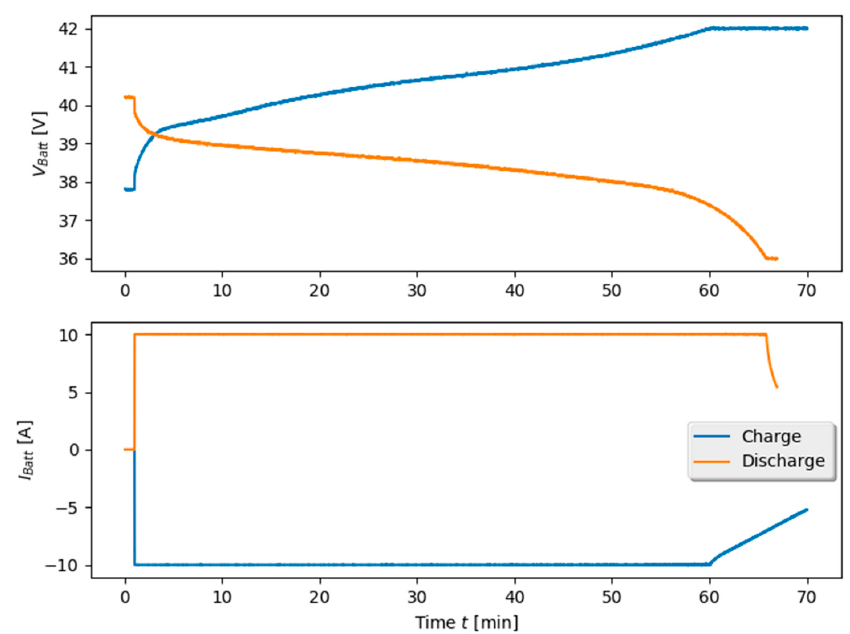
7 of 18 Figure 5. Capacity at charge (up-pointing triangles) and discharge (down-pointing triangles) of three